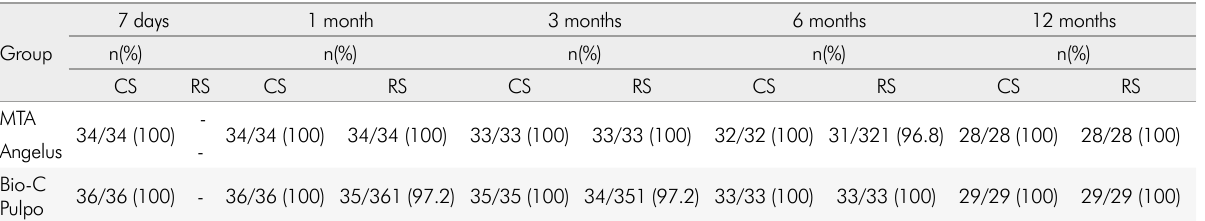
Table 3. Clinical (CS) and radiographic success (RS) rate (%) following pulpotomy at the seven-day (CS), and one-, three-, six- and 12-month follow-ups.